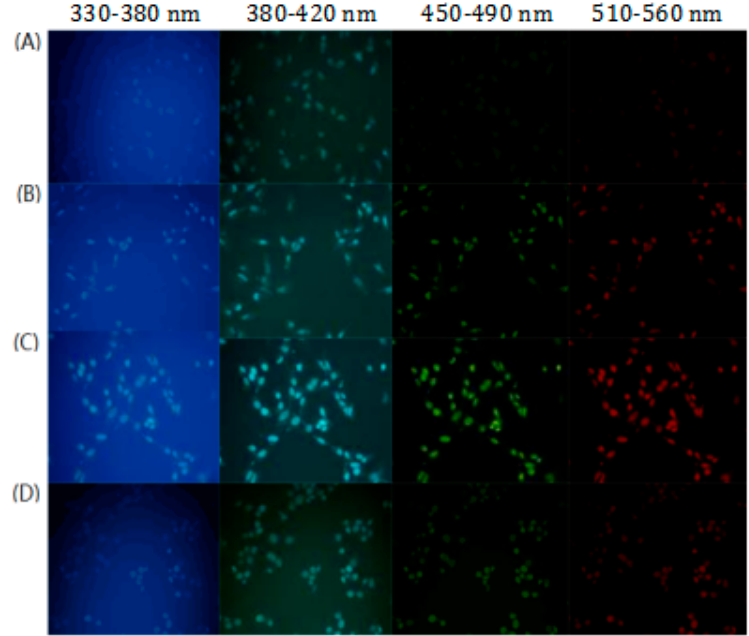
Figure 5. ( A – C ) Fluorescent images of living Hela cells with different concentration of N-CQDs (0.8 mM, 1.354 mM and 1.6 mM) at varied excitation wavelength. ( D ) Fluorescent images of living HCerEPic cells with N-CQDs (1.6 mM) at varied excitation wavelength.